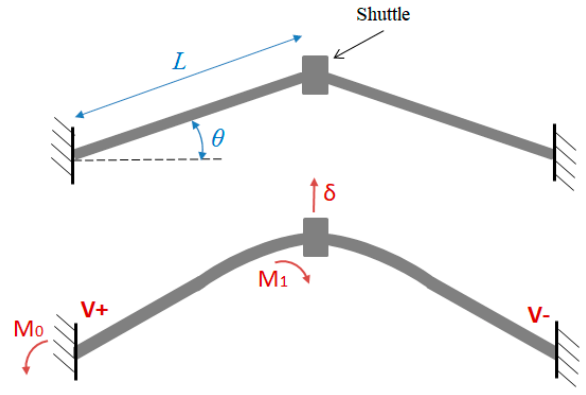
Figure 5. V-shape actuator: geometry and loads.